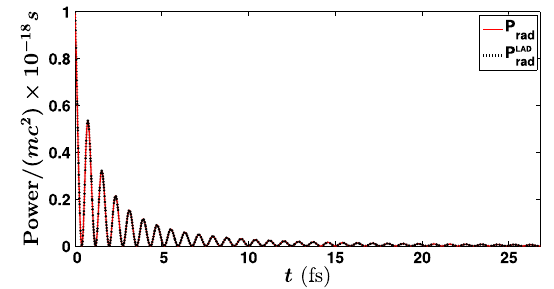
FIG. 2. Comparison of P linearly polarized plane wave with parameters given in Fig. 1.